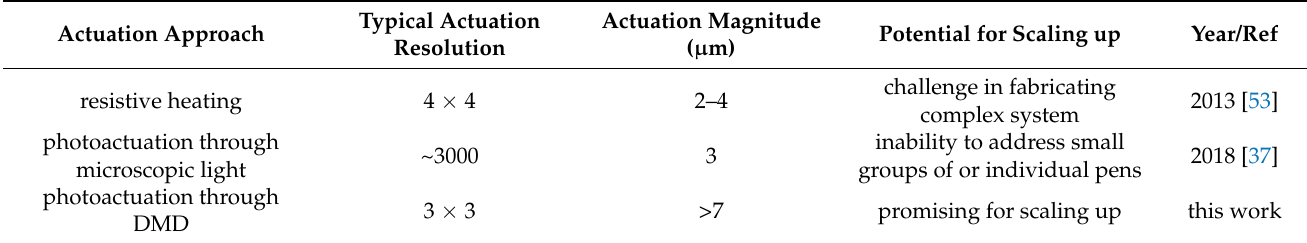
Table 1. Summary of the strategies for the dynamic actuation of polymer